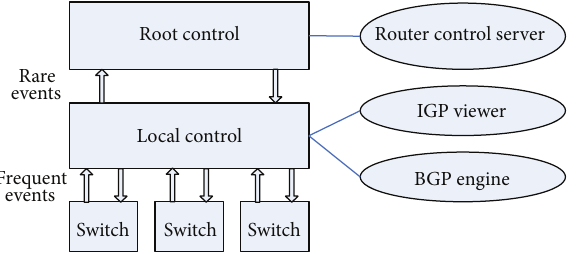
Figure 3: Improved Kandoo architecture based on RCP. Algorithm 1: Steps of the process of BGP route